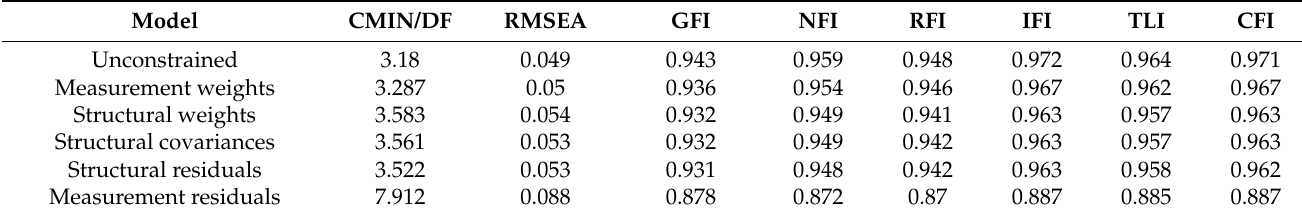
Table 8. Model adaptation table.